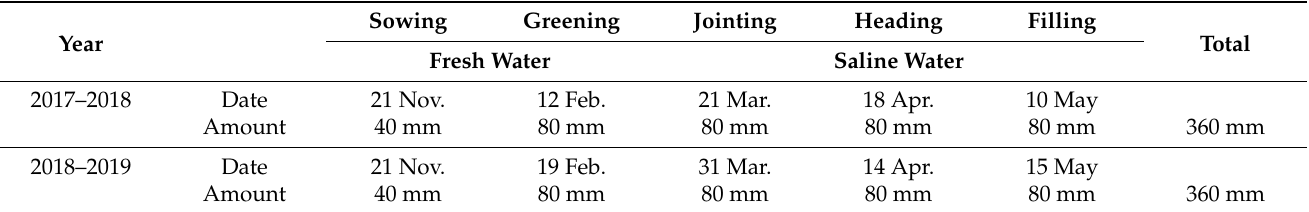
Table 2. Irrigation regime for winter wheat growth during two growing seasons.